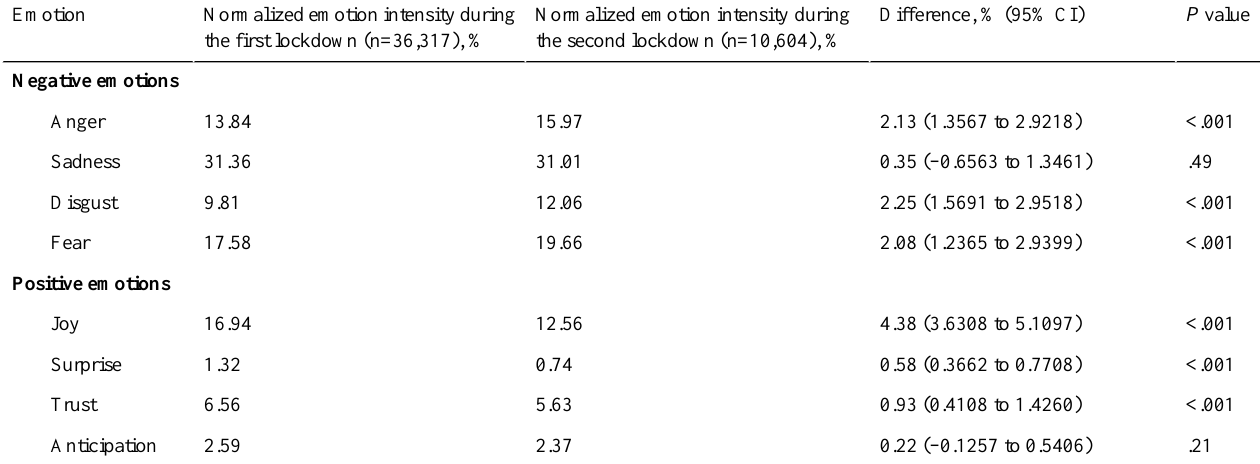
Table 3. Comparison of emotion intensities between the first and second